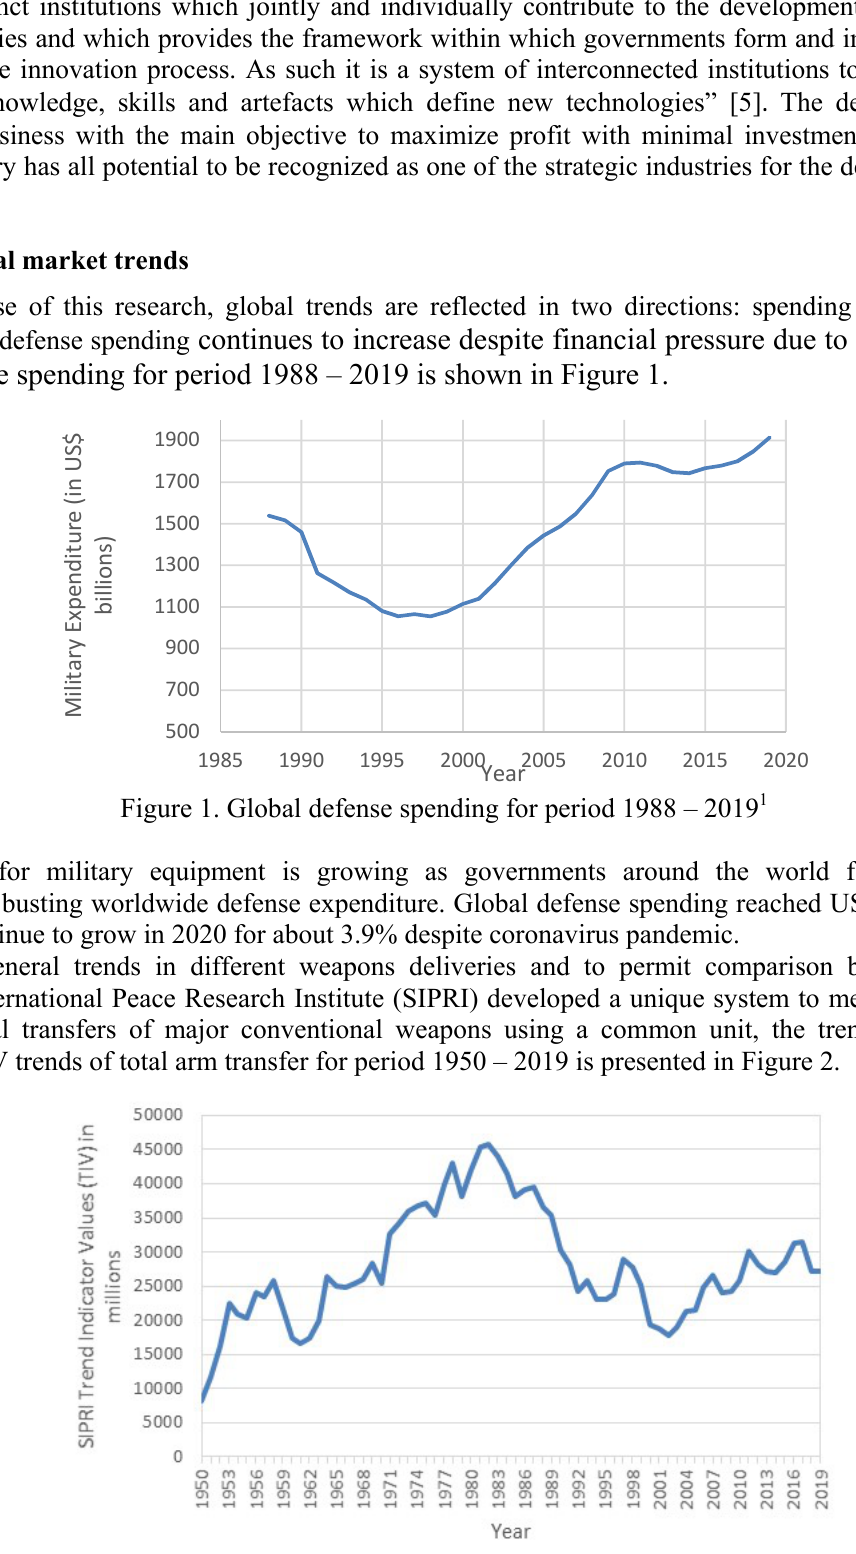
Figure 2. Total arms transfers for period 1950 – 2019